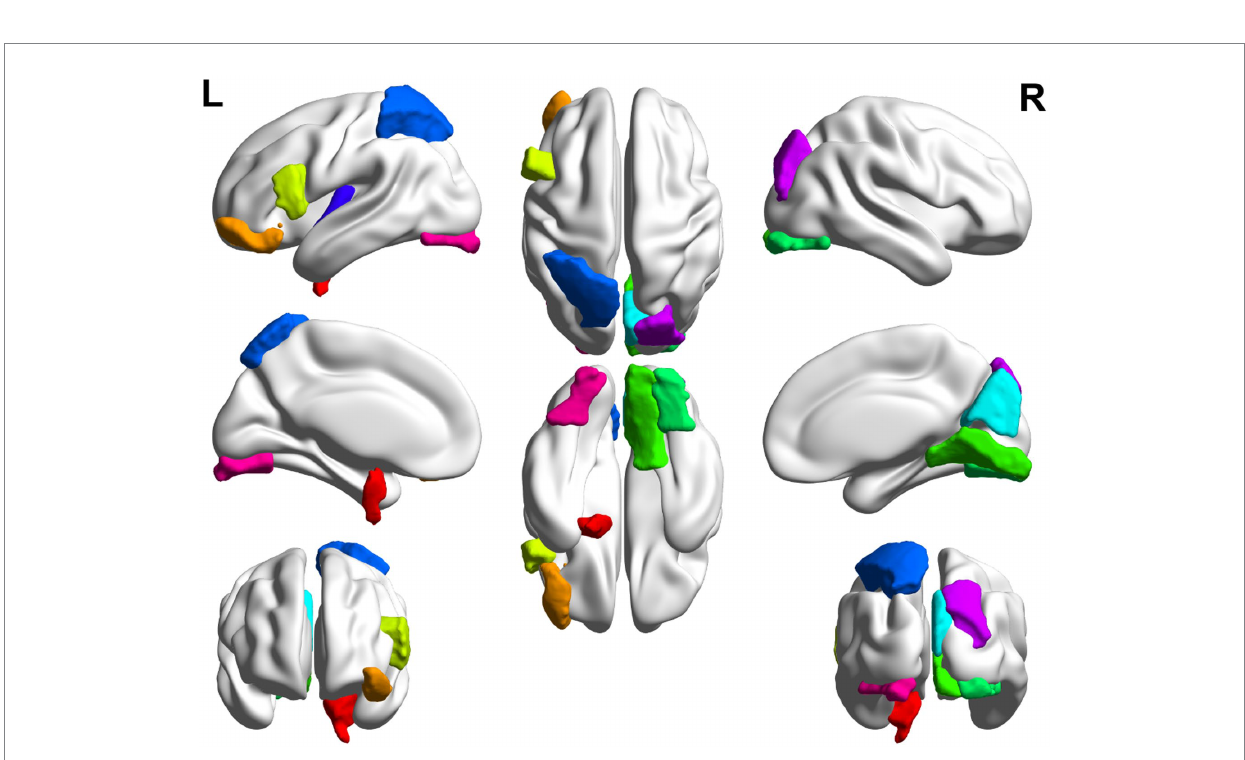
FIGURE 7 Top 10 ROI visualization of MCI